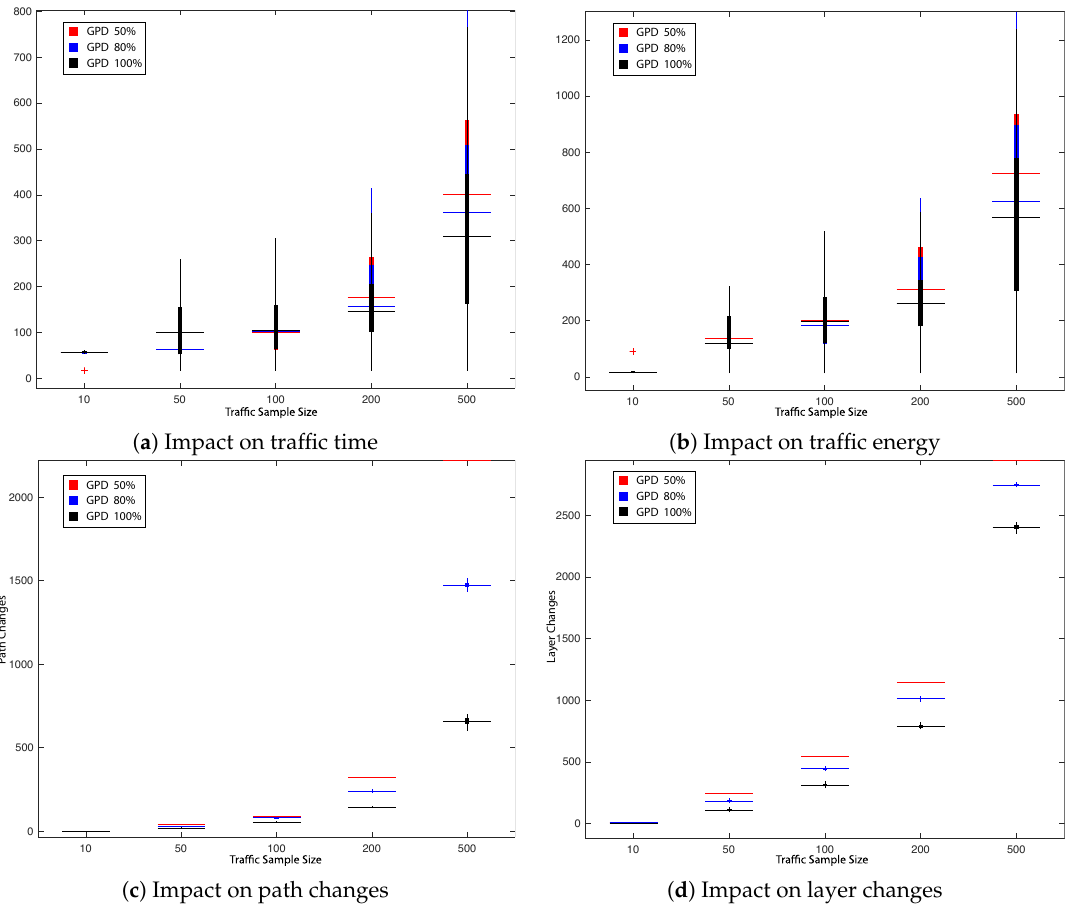
Figure 8. Impact on traffic performance by varying p rerouting in GPD (50%, 80%,